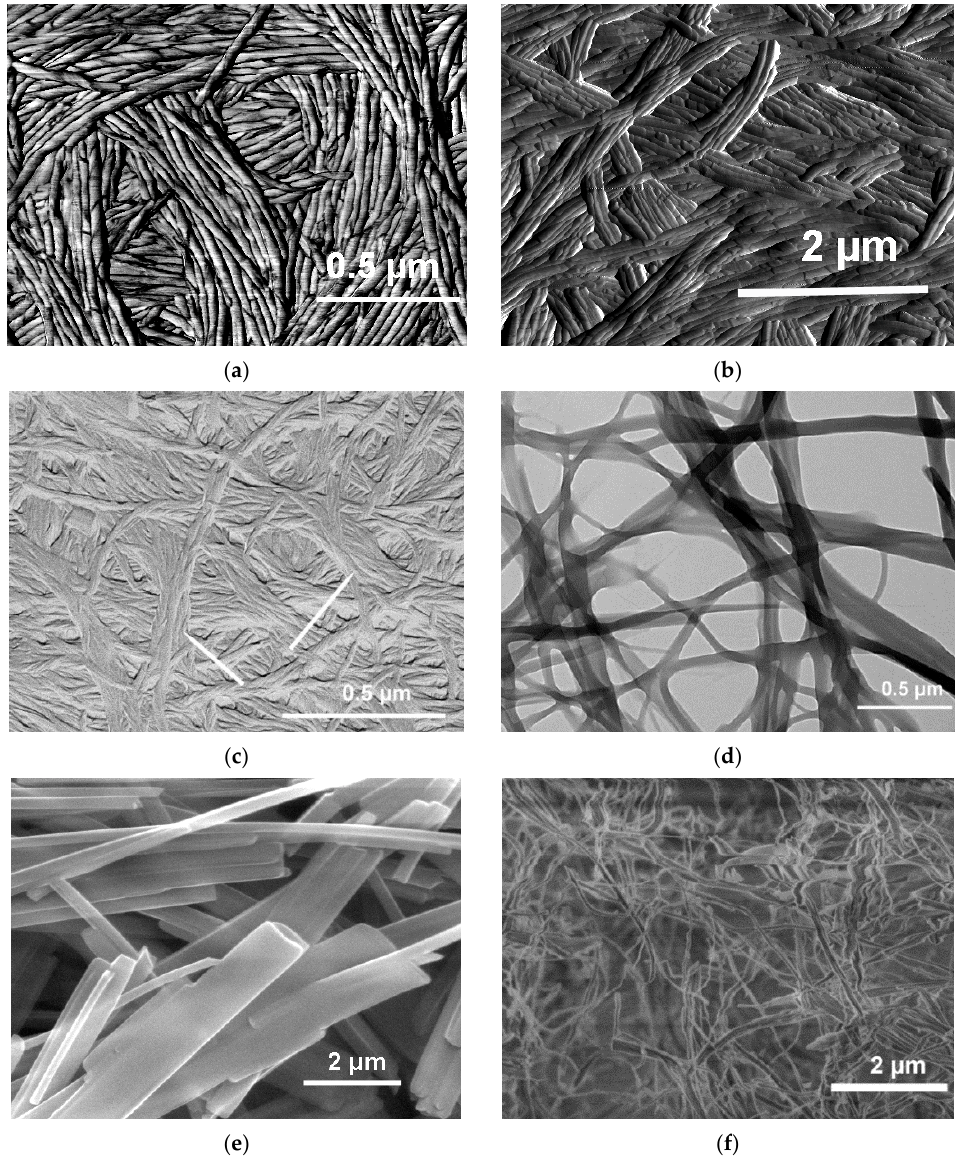
Figure 9. ( a ) AFM micrograph of BHPB-10/ trans -decahydronaphthalene. Nanotubes arise from the twisting and fusion of lamellae ( b ) AFM micrograph of BHPB-10/cis-decahydronaphthalene. ( c ) SEM micrograph of BHPB-10/ o -xylene gels, arrows indicate domains where fibrils twist around one another. ( d ) TEM micrograph of OPVR/ trans -decahydronaphthalene gels. ( e ) SEM Propargyl Ammonium-Based molecule/H 2 O (chemical structure Appendix Figure A4 ( f )) SEM TATA/bromobenzene gels. [13,14,33,34].